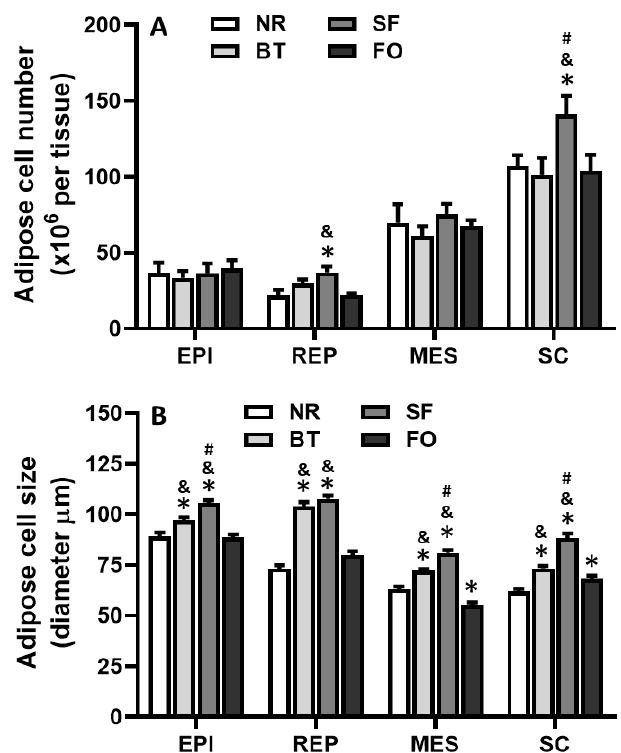
Figure 5. Comparison of adipose cell number ( A ) and cell size ( B ) in the epididymal (EPI), retroperitoneal (REP), mesenteric (MES) and subcutaneous (SC) fat pad of rats after feeding of different diets for 4 weeks. mean ± SE.; n = 6, * p < 0.05, vs. normal rodent diet (NC); & p < 0.05, vs. fish oil (FO), and # p < 0.05, vs. beef tallow (BT).